Question: Write a single sentence explaining what this figure depicts.
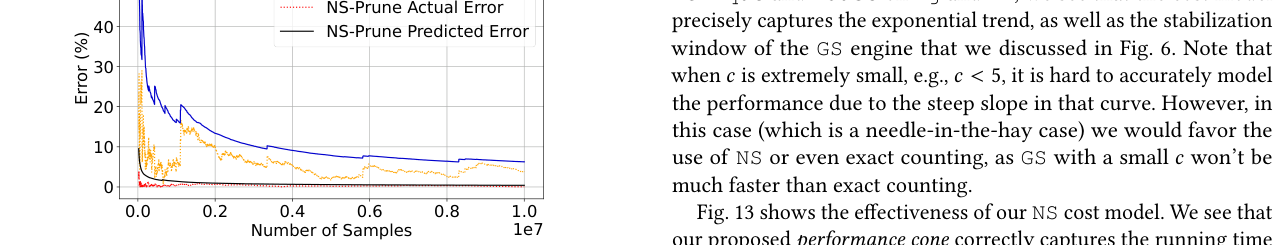
Answer: Comparison between the convergence rate of NS-prune and NS-base. The same formula (with two standard deviations of confidence) was used to generate the error estimate curves.